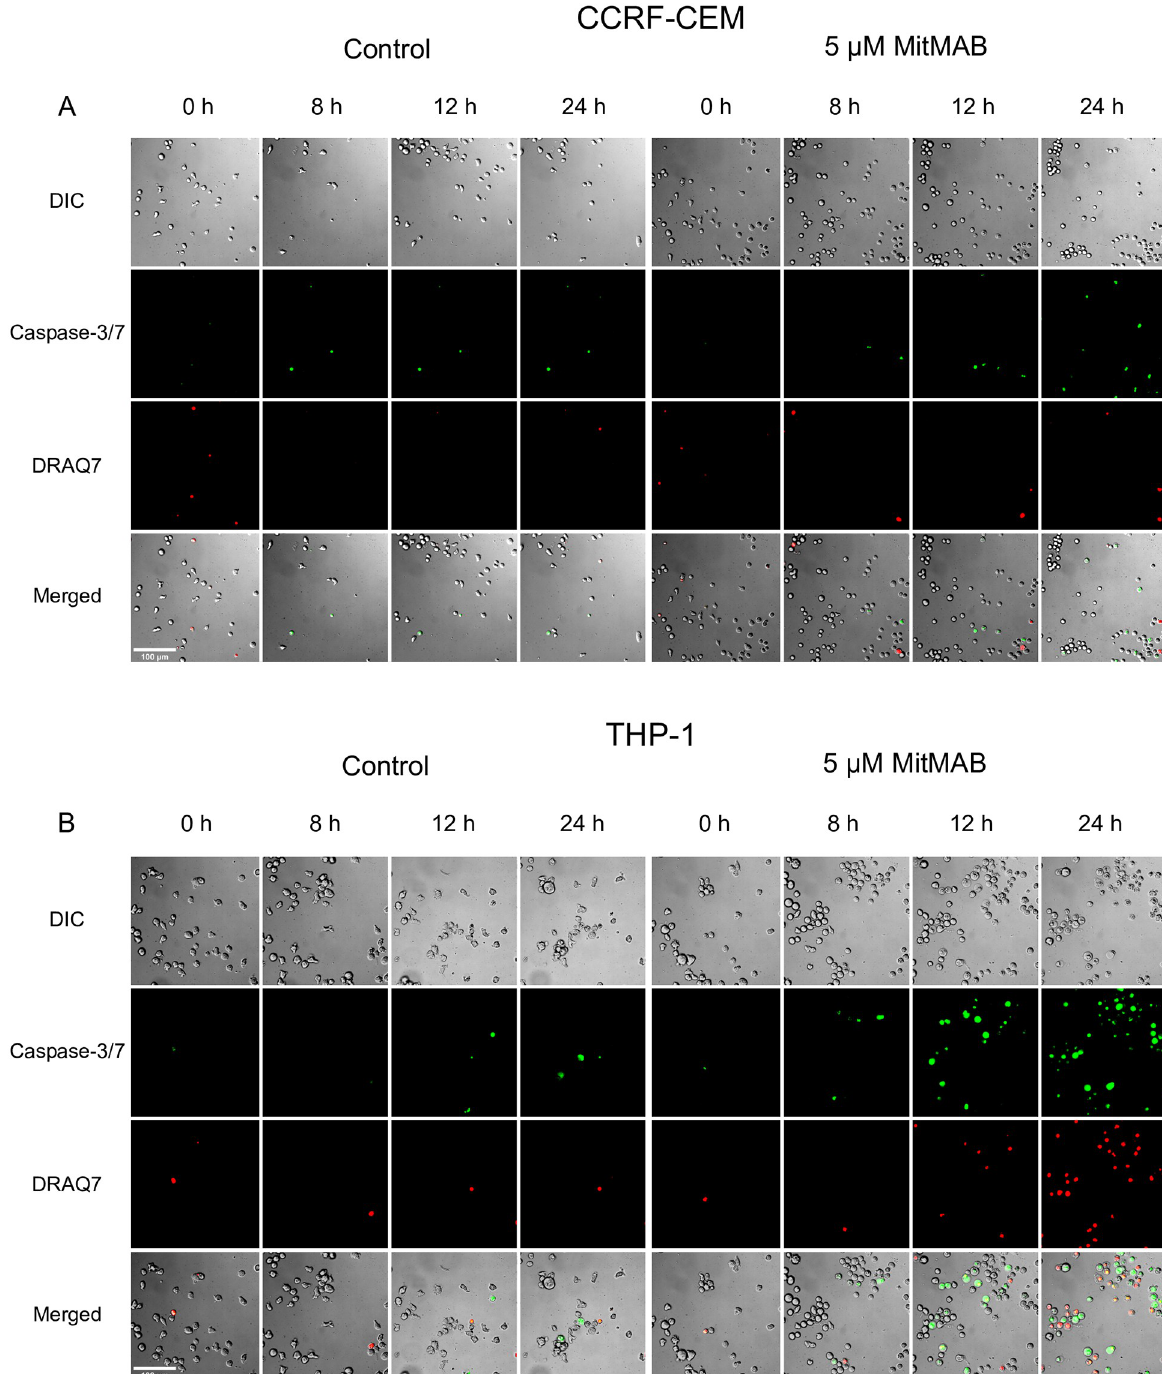
Fig 5. Caspase activation precedes overt cell death in leukemia cells subjected to dynamin inhibition. 0.15 x 10 6 of CCRF-CEM (A) or THP-1 (B) cells/ml in medium containing 150 nM DRAQ7 and 500 nM caspase-3/7 probe were added to chamber slides, followed by addition of MitMAB (5 μ M final concentration) as indicated. Every 10 min, images of every well were taken. The indicated DIC, fluorescence, or merged channels are shown. Scale bars = 100 μ m. Representative images of two wells per condition are shown (see also S1–S4 Movies).